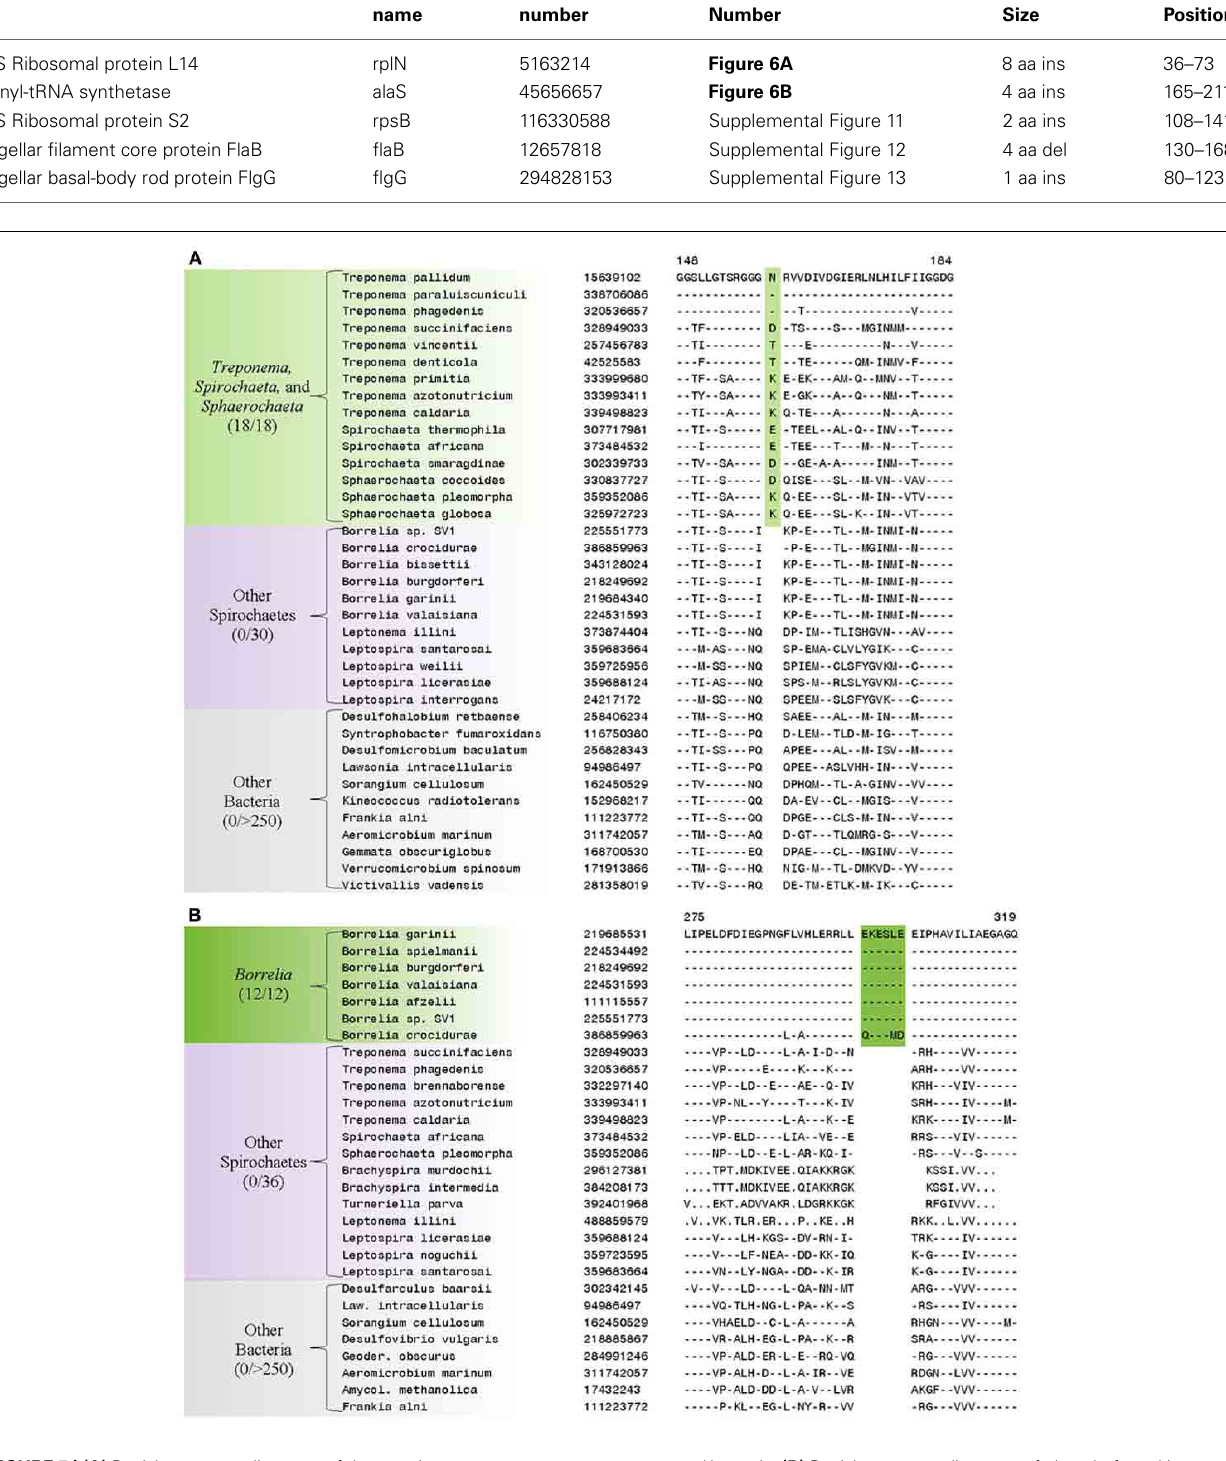
FIGURE 7 | (A) Partial sequence alignment of the protein 6-phosphofructokinase (pyrophosphate) containing a 1 amino acid insert in a conserved region that is specifically present in the species from the genera Treponema, Spirochaeta, and Sphaerochaeta , but not found in any